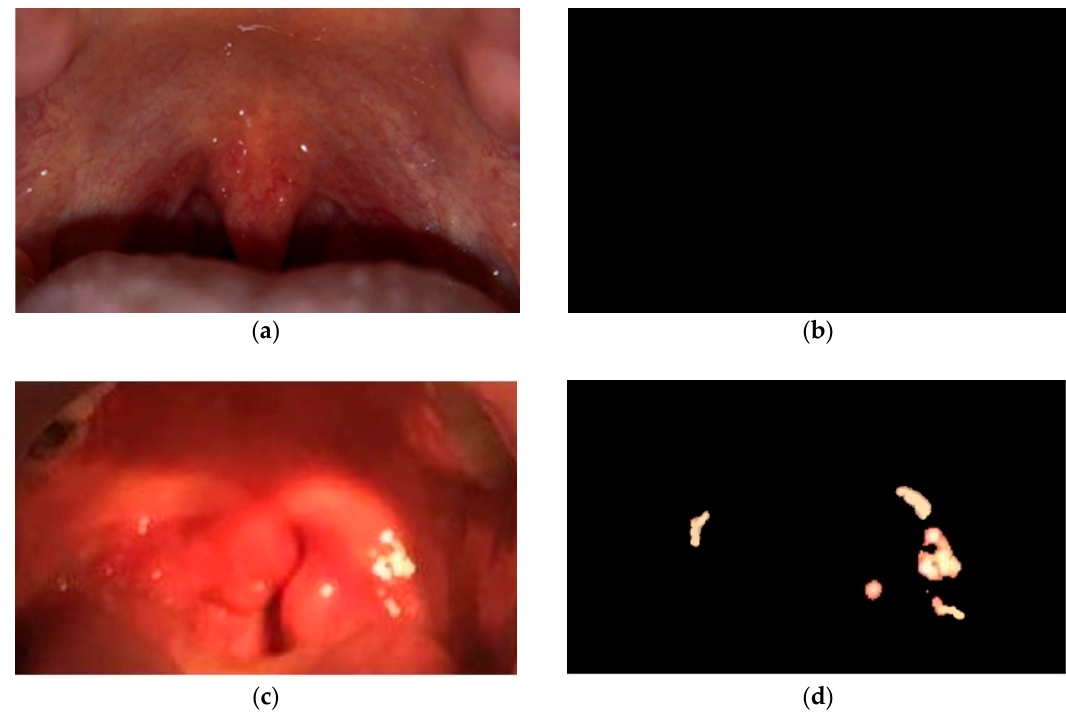
Figure 14. Detection of strep throat tissue using the proposed method. ( a ) Original image of a healthy throat, ( b ) the throat in (a) is diagnosed to be healthy (no infected tissue is detected in the image), ( c ) original image of a diseased throat, and ( d ) the throat in (c) is diagnosed to be infected (infected tissue is marked in bright color).